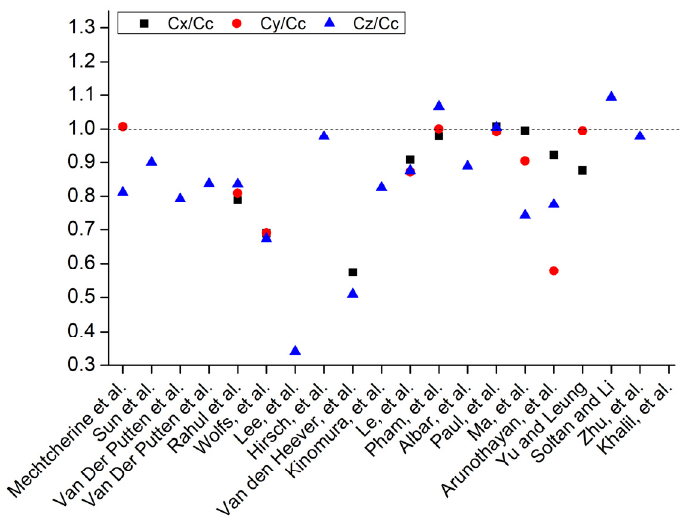
Figure 7. Anisotropy in compressive strength of 3D-printed concrete [1,49,61,92,127,135,165,175– 186].